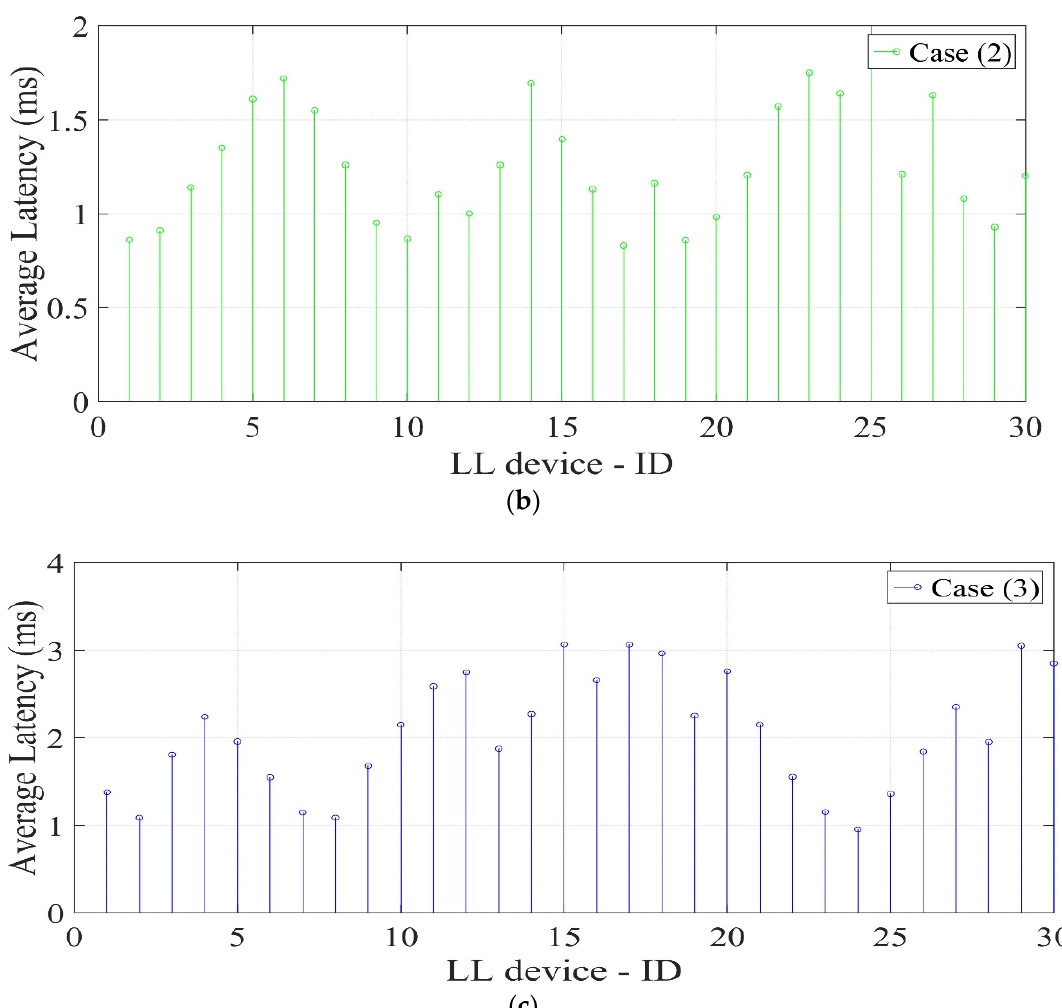
Figure 9. Average latency of handling LL devices’ tasks for the three considered cases of the first scenario. ( a ) Average latency for case (1), ( b ) Average latency for case (2), and ( C ) Average latency for case (3).